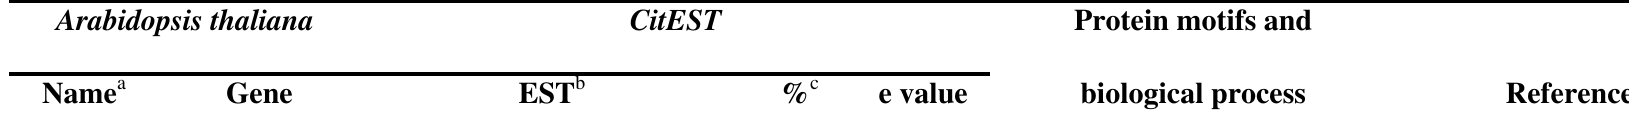
Table S2 –Citrus ESTs with homology to the major intrinsic protein (MIP) gene family from Arabidopsis thaliana and other model